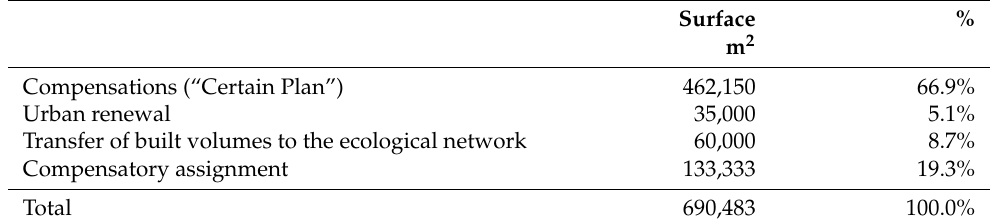
Figure 13. Left. hypothesis of distribution of the public SUL. Right. Compensations (Variant of Certainties) (Source: elaborations by the author). Table 9. Compensation hypothesis (“Certain Plan”). Table 10. Hypothesis of areas acquired for public assets (outside CUM) destined for green areas services and the Agro romano.